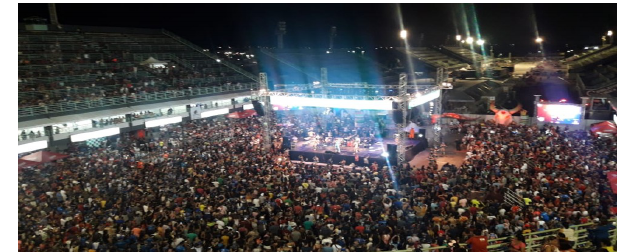
Figure 5. Image of the Carnaboi 2020 event. Source: Portal Beiju.